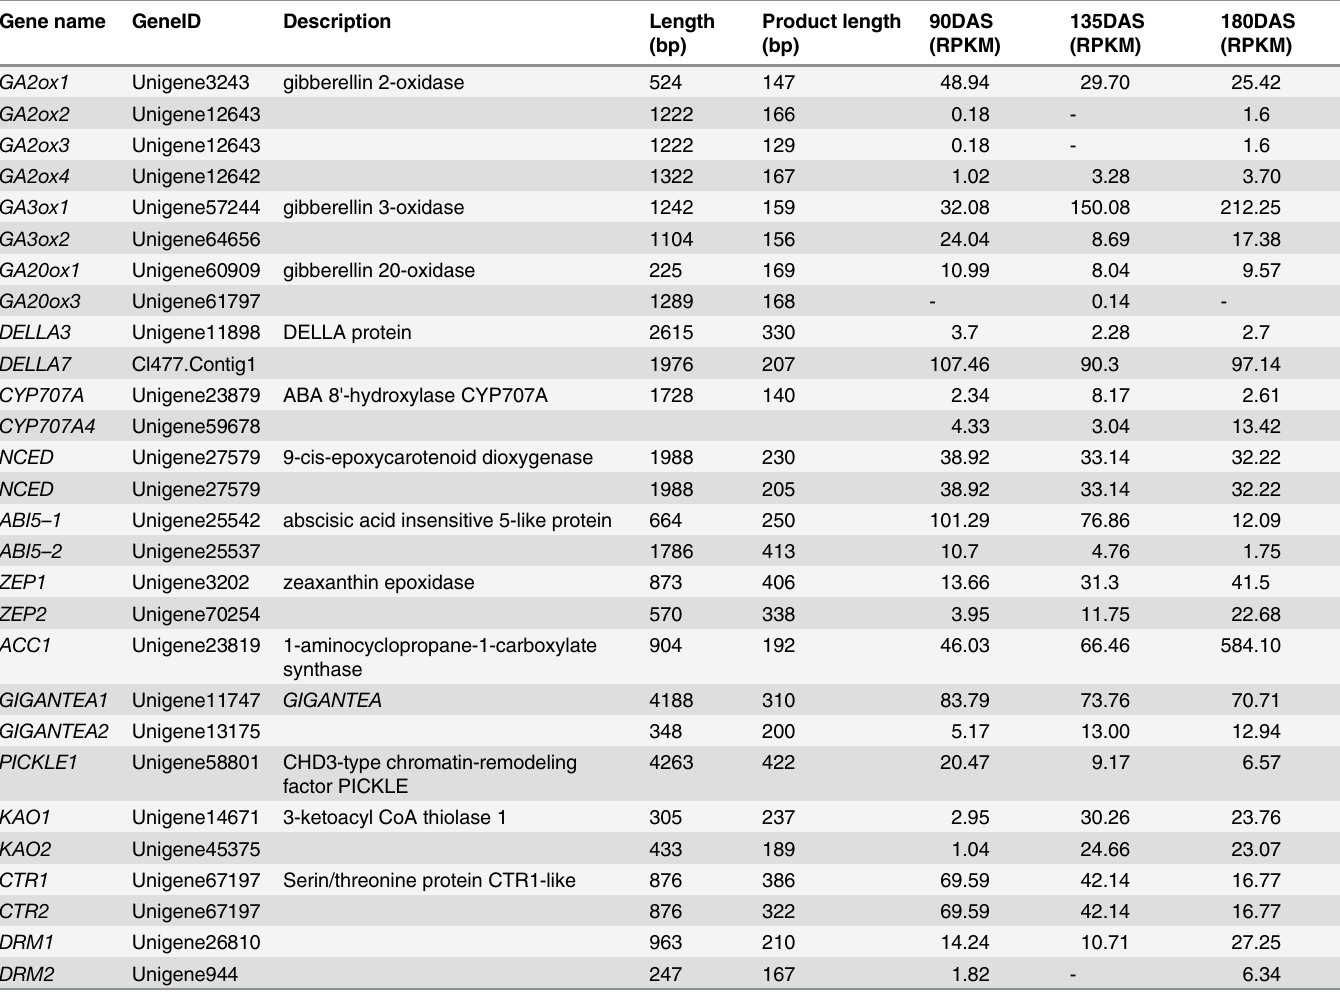
Table 4. Different expression of The RPKM Studied genes in quantitative